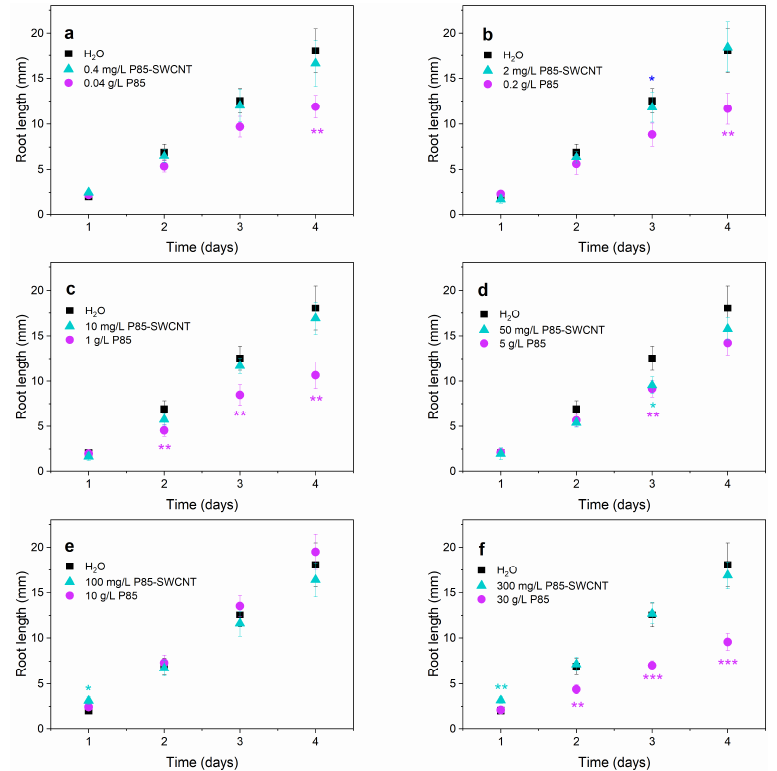
Figure 1. Root length of hydro-, P85-SWCNT-, and P85-primed pea seeds for the initial 4 days after seeds sowing. Data for 0.4 mg/L ( a ), 2 mg/L ( b ), 10 mg/L ( c ), 50 mg/L ( d ), 100 mg/L ( e ) and 300 mg/L ( f ) P85-SWCNT (triangles), as well as the corresponding P85 treatments (circles), are presented in different panels. For clarity each panel contains data for hydro-primed samples (squares) as well. Mean ± SE. Statistically significant differences from the control sample at p < 0.1 (*), p < 0.05 (**) and p < 0.01 (***) according to Student’s t -test are